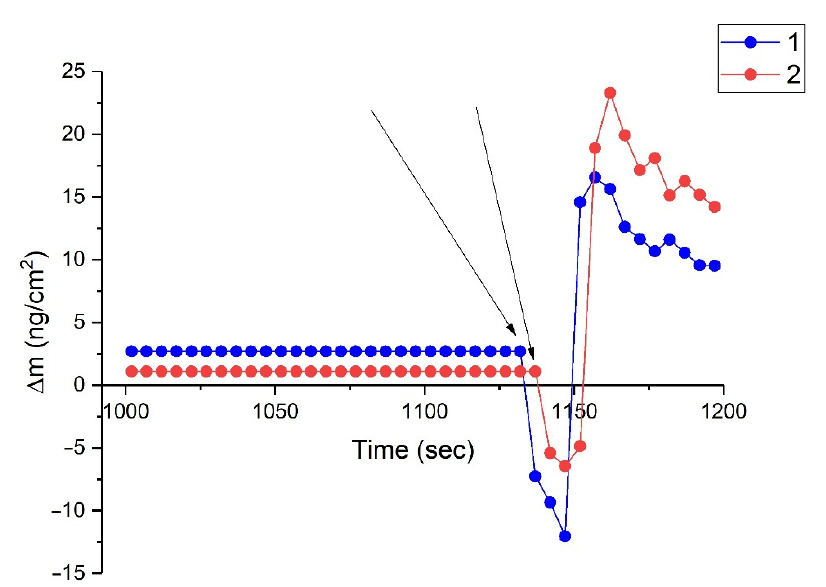
Figure 1. Kinetics of organosilanes adsorption on the surface of freshly sprayed aluminium from aqueous solution: ( 1 ) DAS; ( 2 ) VS. ↓ addition of organosilanes to aqueous solution to concentration equal 1 × 10 − 5 M.